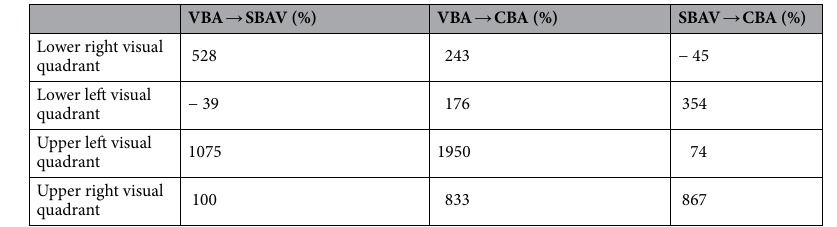
Table 2. Changes of group ROI size compared between alignment methods. We used the following formula: {(size_ROI Quad [AM m ] − size_ROI Quad [AM n ])/size_ROI Quad [AM n ]} × 100. For SBAV compared to VBA, we observed a group ROI size increase in three out of four visual quadrants. For CBA compared to VBA, we observed a group ROI size increase in all four visual quadrants. For CBA compared to SBAV we observed a group ROI size increase in three out of four visual quadrants. Quad visual quadrant of interest, AM alignment method (VBA, SBAV, CBA). n and m specify AMs, with m referring to the less advanced AM and n referring to the comparatively more advanced AM.